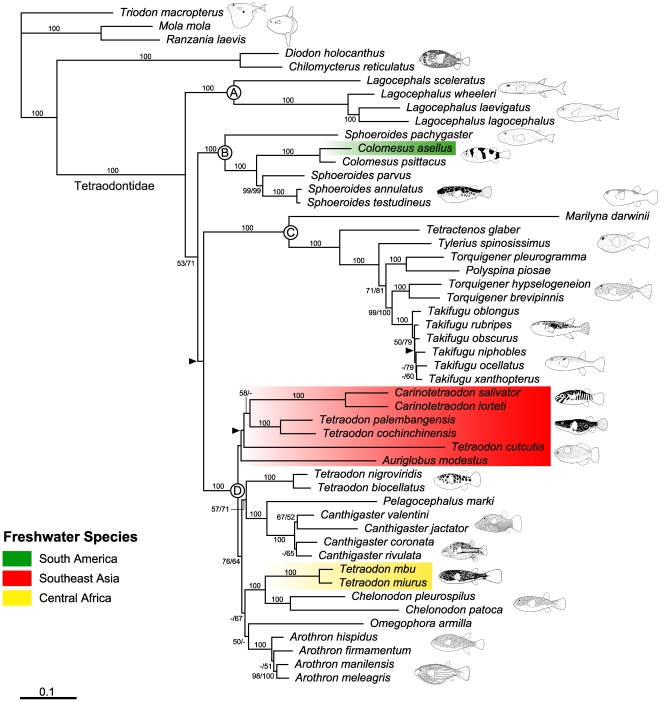
An ML tree with estimated branch lengths using the 12n3rRTn dataset.Topological differences between the ML analysis for the 12n3rRTn and 123nRTn datasets are indicated by arrowheads. Numbers near internal branches indicate ML bootstrap probabilities for the 12n3rRTn (left) and 123nRTn (right) datasets (values less than 50% not shown). Single numbers indicate that these estimates were identical.